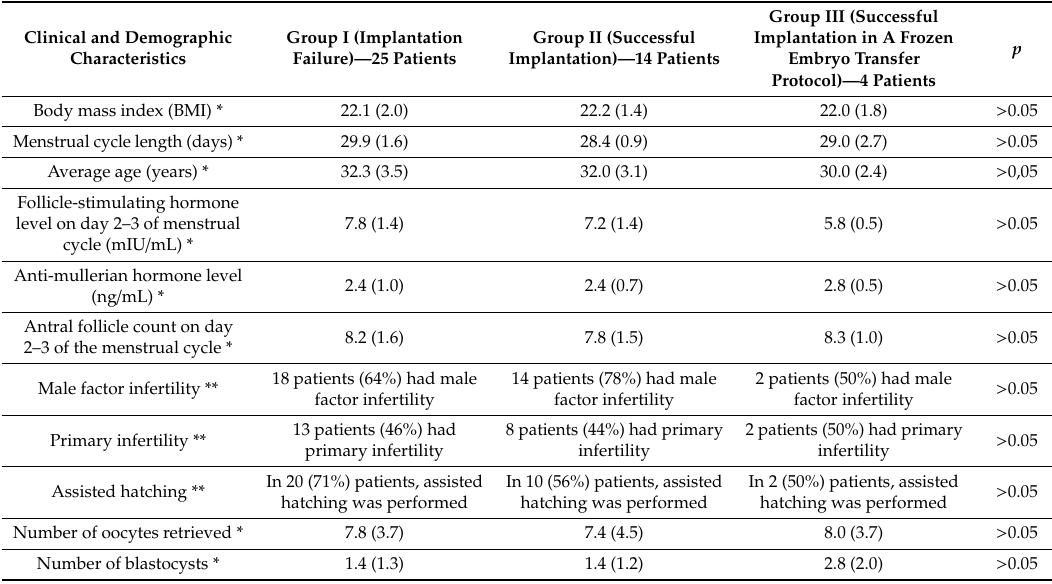
Table 5. Comparison of the clinical and demographic characteristics of patients enrolled in the current